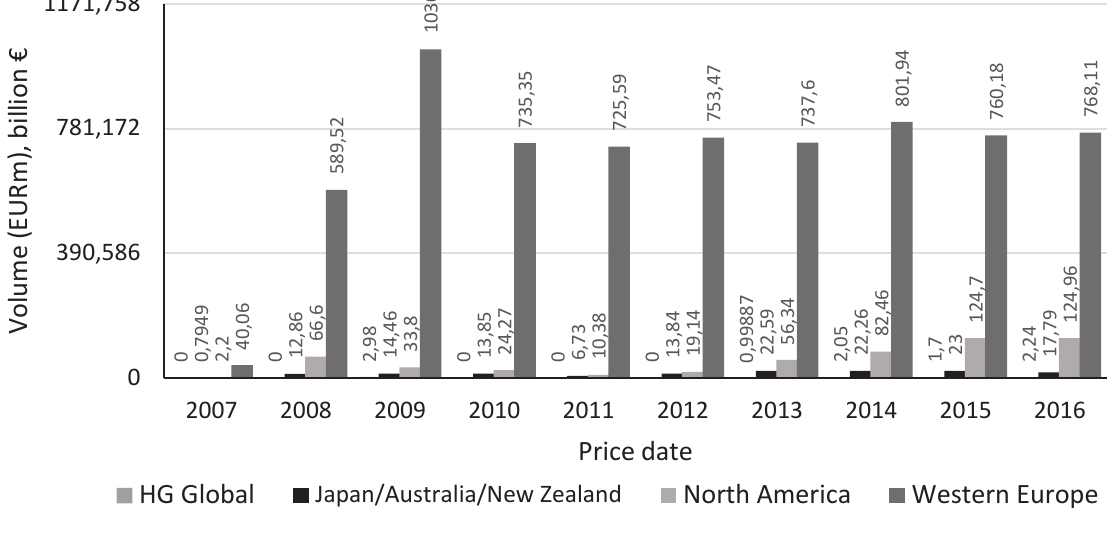
Figure 3. Volume of issued bonds by